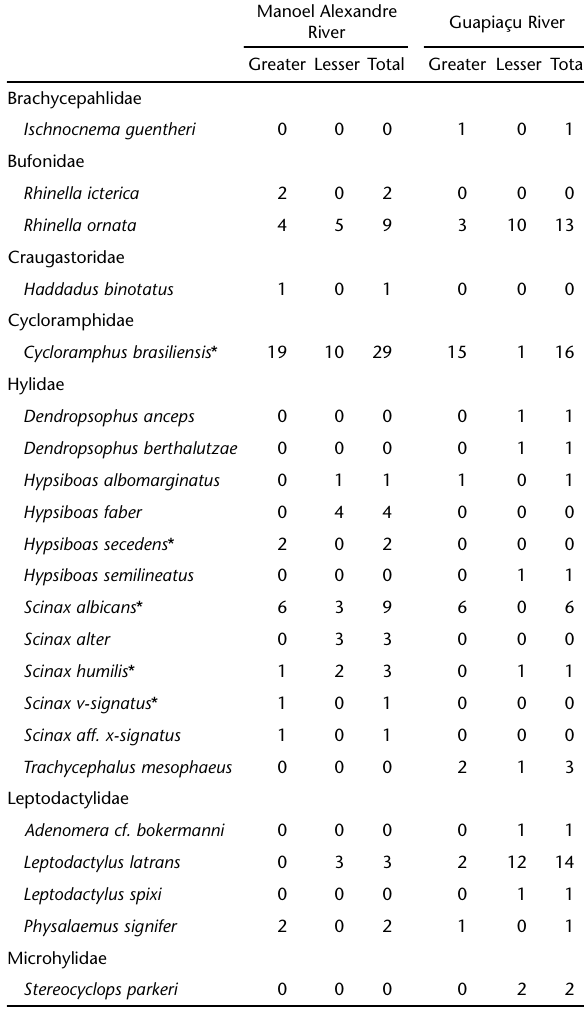
Table I. Number of individuals of amphibian species recorded during Visual Encounter Surveys in two rivers with high and low forest cover portions in the municipality of Cachoeiras de Macacu, state of Rio de Janeiro, Brazil.